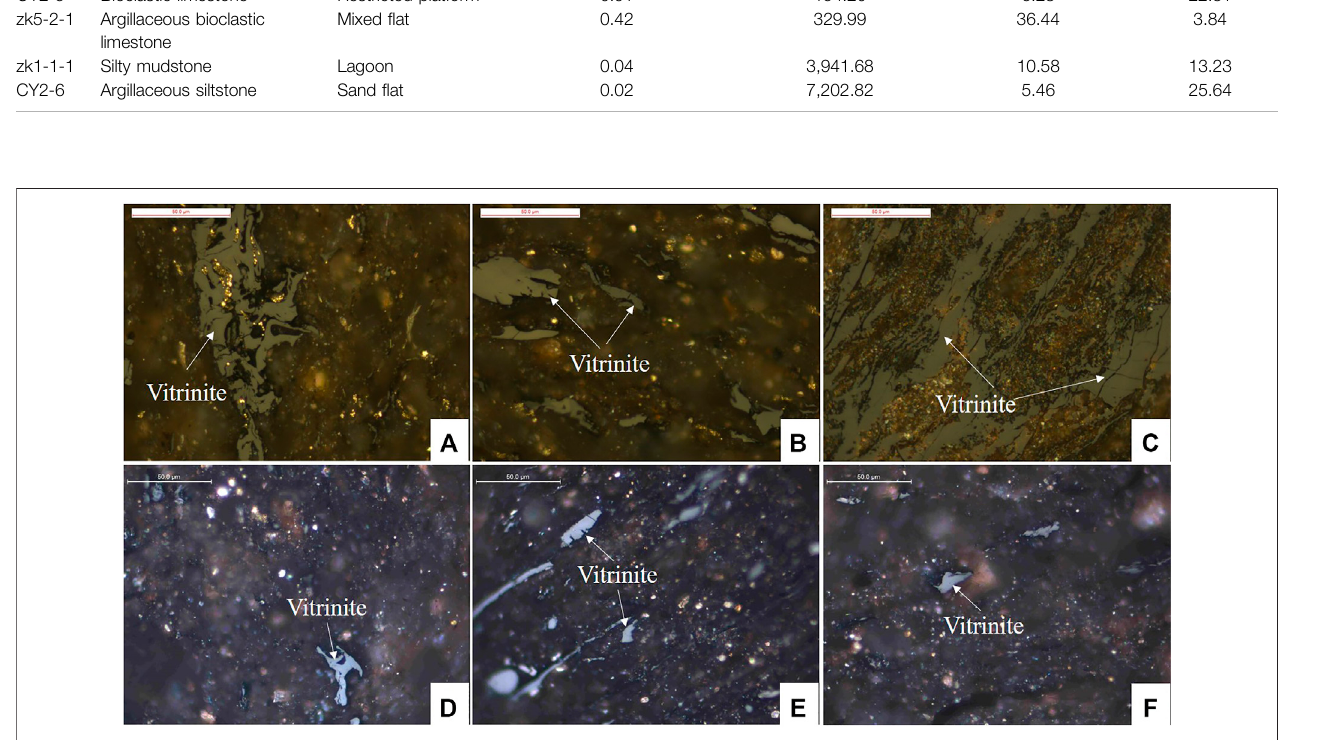
Frontiers in Earth Science |